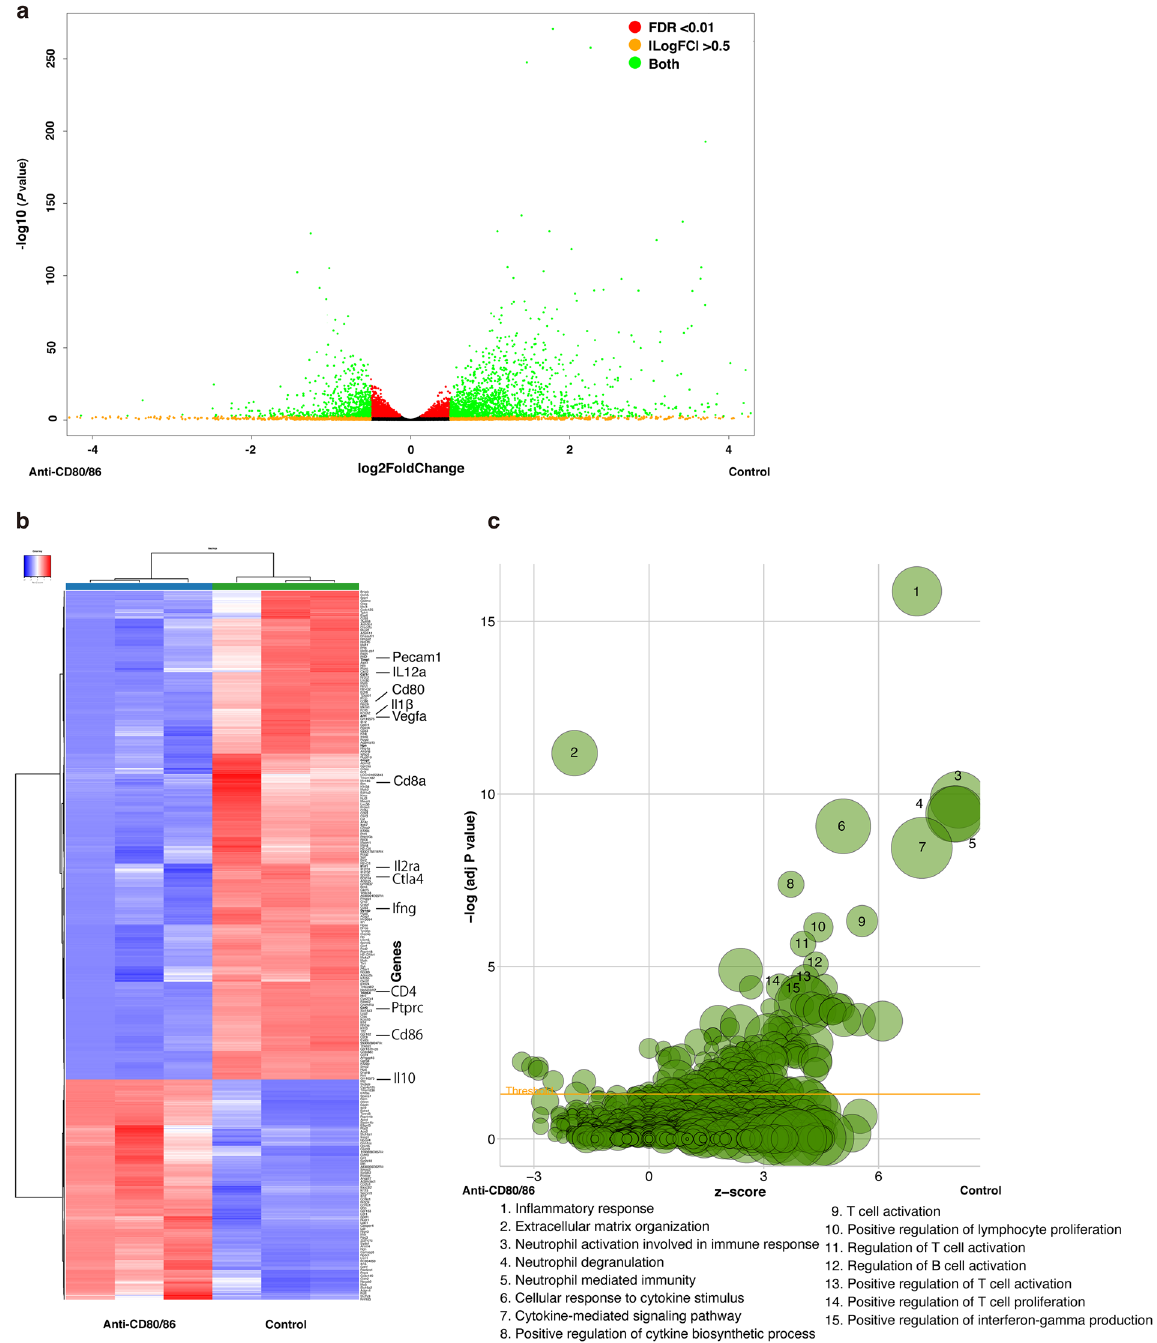
Figure 6. Differentially expressed genes and GO terms of differentially expressed genes between anti-CD80/86 injection and control corneal grafts. ( a ) Volcano plot of differentially expressed genes (DEGs) of corneal grafts between the anti-CD80/86 and phosphate-buffered saline (PBS) injection groups (control). The gene sets with a false discovery rate (FDR) of less than 0.01 were used as a threshold to determine the significance of DEGs. Green dots represent DEGs, and red dots indicate transcripts that did not significantly change between the anti-CD80/86 and PBS injection groups (control). ( b ) Hierarchical clustering of DEGs between the anti-CD80/86 injection group and the PBS injection group (control). The X axis represents the two compared samples (anti-CD80/86 injection and PBS injection group). The Y axis represents DEGs. The color (from blue to red) represents gene expression intensity from low to high. ( c ) The bubble plot of Gene Ontology terms. The z-score is assigned to the X axis and the negative logarithm of the P value to the Y axis, as observed in the bar plot (the higher the more significant). The area of the displayed circles is proportional to the number of genes assigned to the terms. Only the immunologically enriched GO terms’ labels are